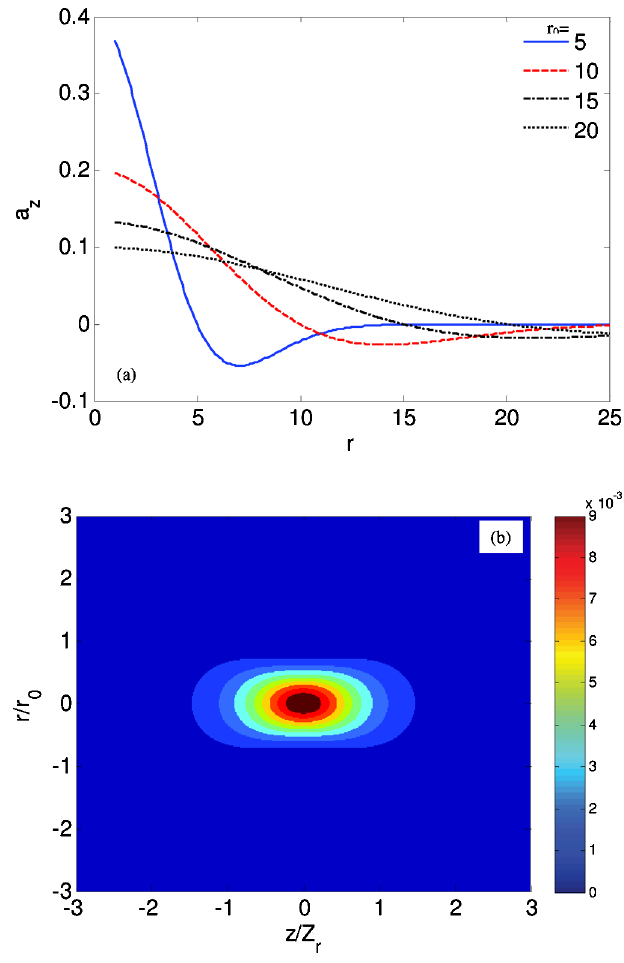
FIG. 2. (a) Normalized axial field intensity as a function of r at z ¼ 0 . (b) The spatial profile of the axial field intensity for 10 . Normalized laser intensity parameter a r 0 ¼